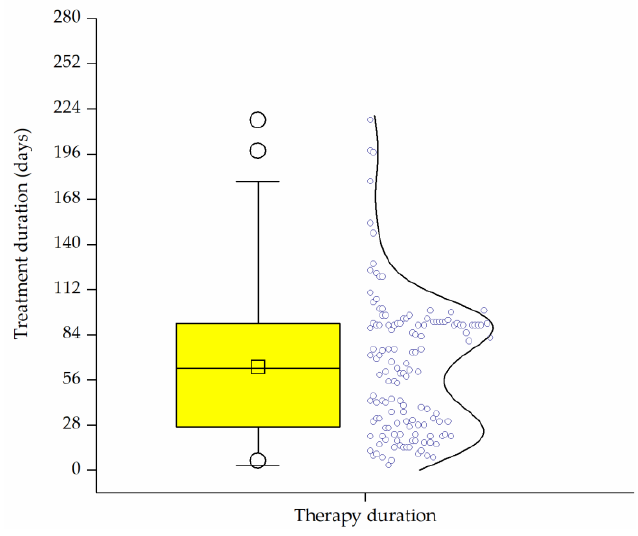
Figure 6. Box plot of treatment duration (days). Individual values are represented by a bimodal distribution density curve ( n = 139). Data show that approximately 75% of the patients were treated for longer than 28